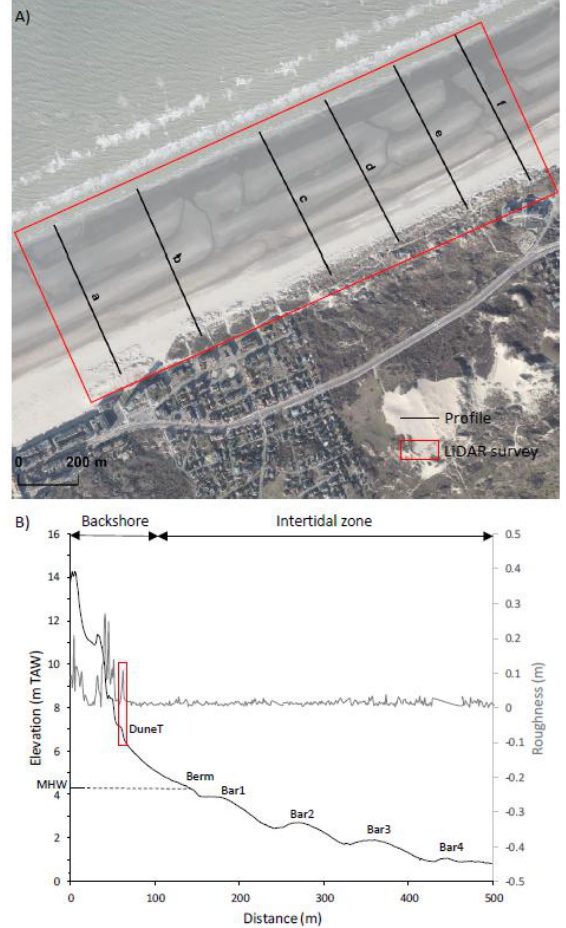
Figure 2. A) Area of the LiDAR surveys and beach profiles location, B) Coastline detections of the MHW and DuneT indicators. DuneT is extracted using the roughness